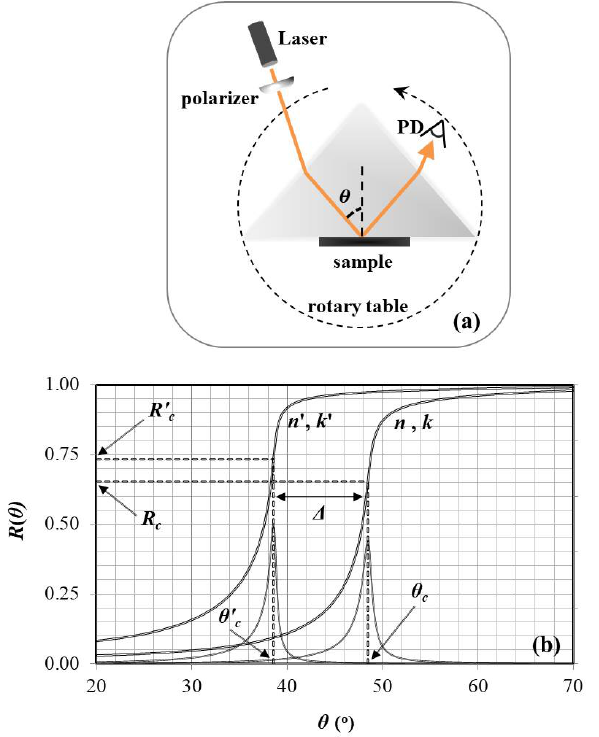
Figure 1. ( a ) A typical prism-coupling refractometer. The sample is attached to the base of a transparent reference prism, which sits on a rotary table. Incoming through the prism’s front facet, a collimated linearly polarized laser beam hits the interface at a variable incidence angle θ . The reflected light exits the prism through its rear facet, heading towards a photodiode (PD), where the reflectance profile R ( θ ) is monitored. ( b ) Fresnel reflectance profiles R ( θ ) at two interfaces between a sample and two different prisms. Bell-like curves are corresponding derivatives dR / d θ , peaking at θ c and θ (cid:48) c . Calculations assume s polarisation and n = 0.75, k = 5 · 10 − 3 , Λ =